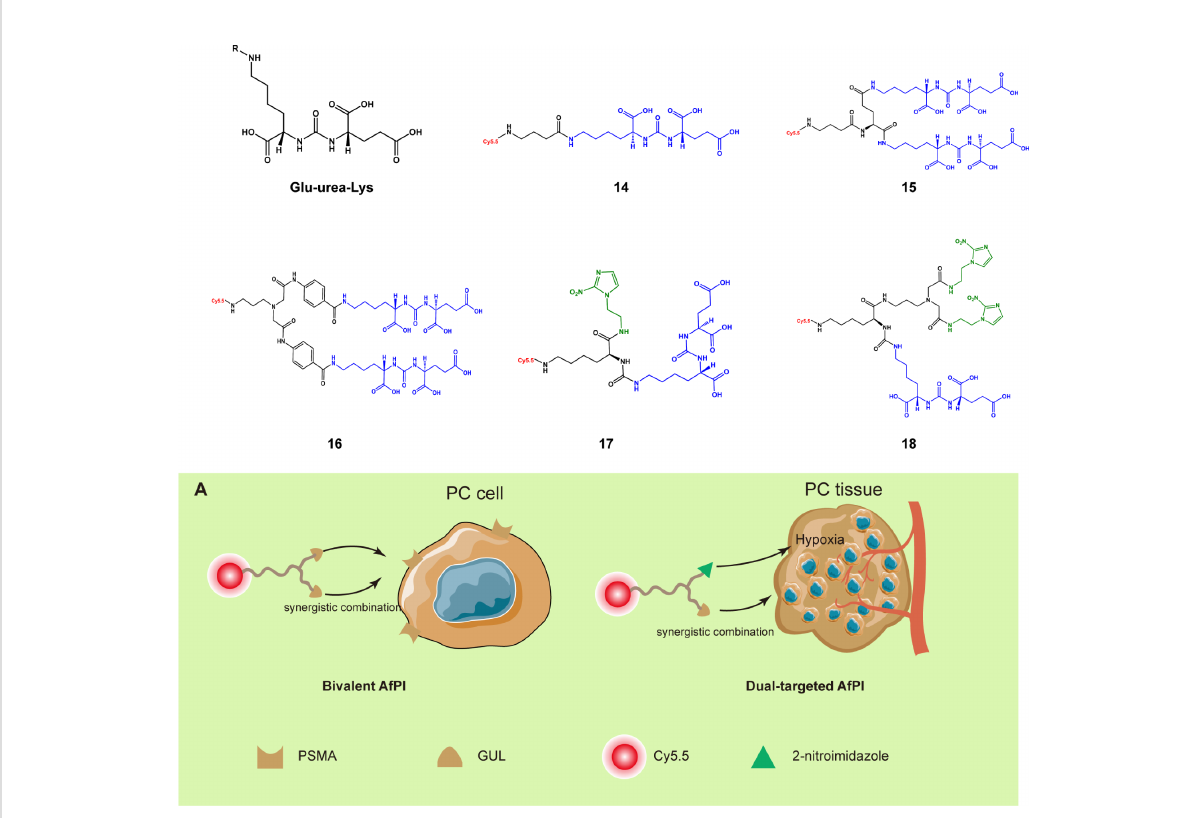
FIGURE 4 Structures of the PSMA inhibitor and its derived AfPIs (Blue, GLU units Green, 2-nitroimidazole group). (A) Schematic of bivalent and dual- targeted AfPIs for prostate cancer (PC, prostate